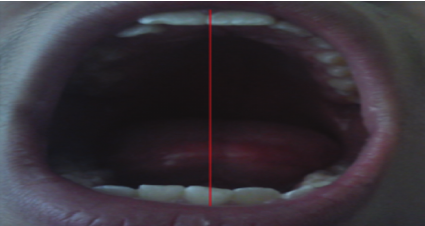
Figure 13: Trismus measurement for a picture concerning a maximum mouth opening. The distance of the mouth opening is 5.9584